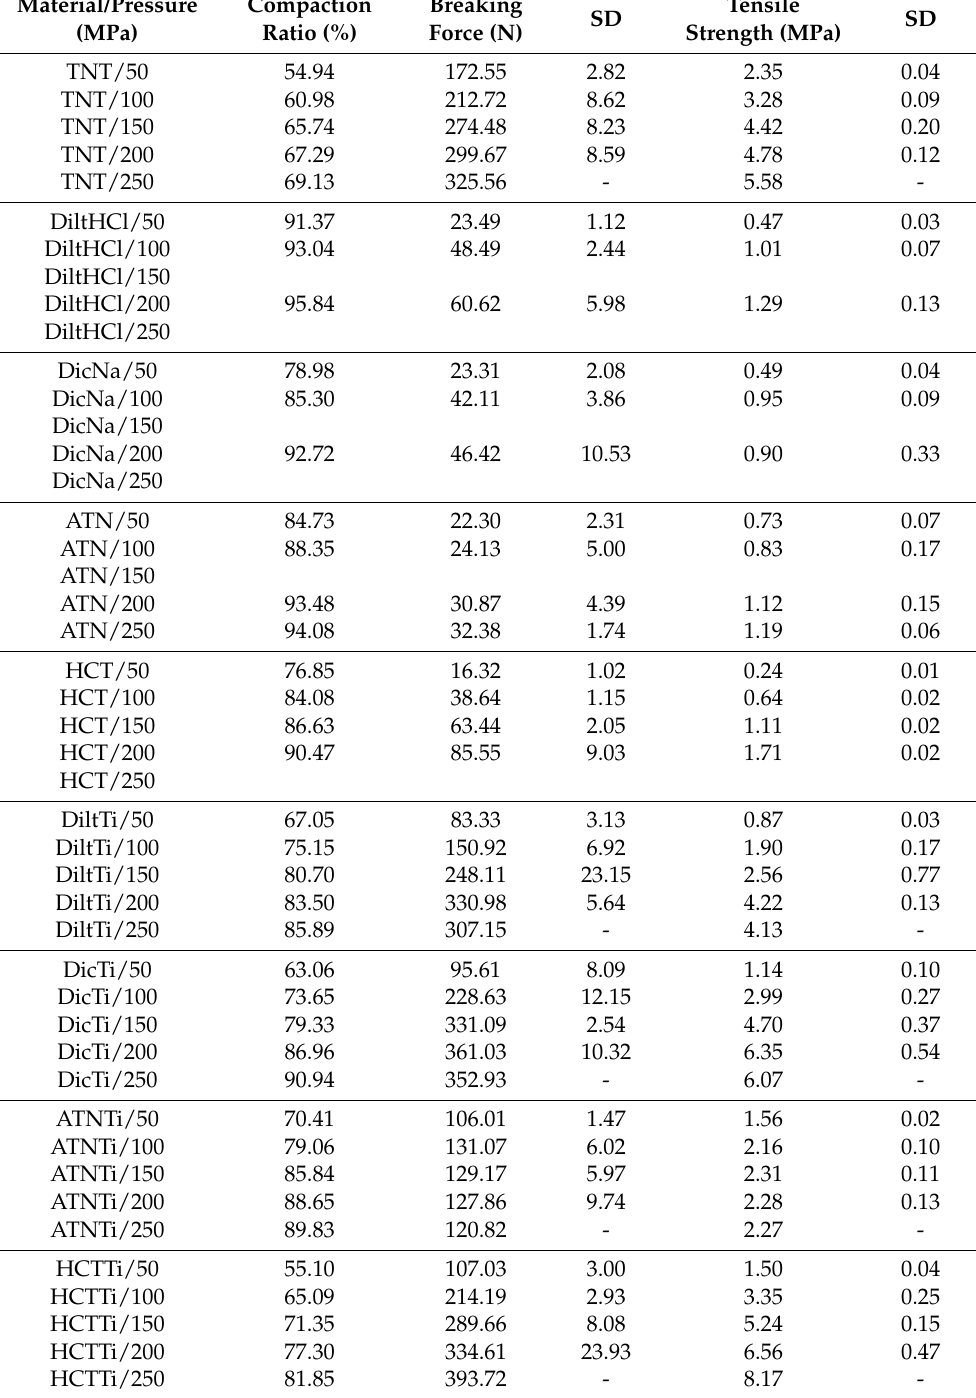
Table 3. Post-compressional properties of the